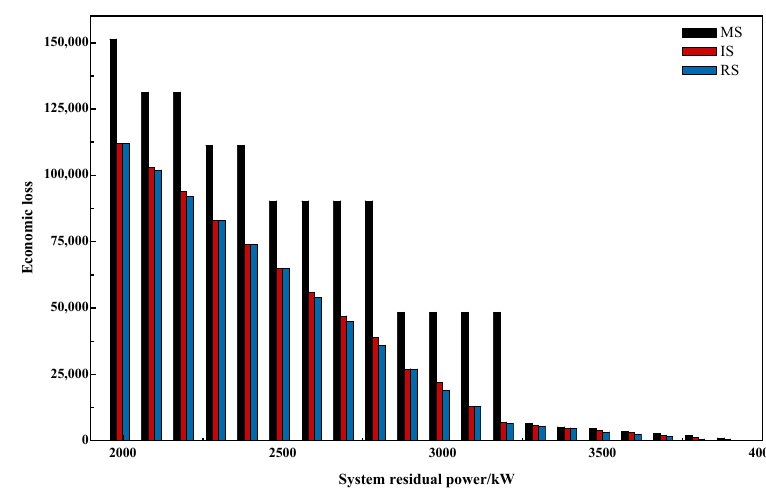
Figure 7. Comparison of the economic loss after the load shedding.